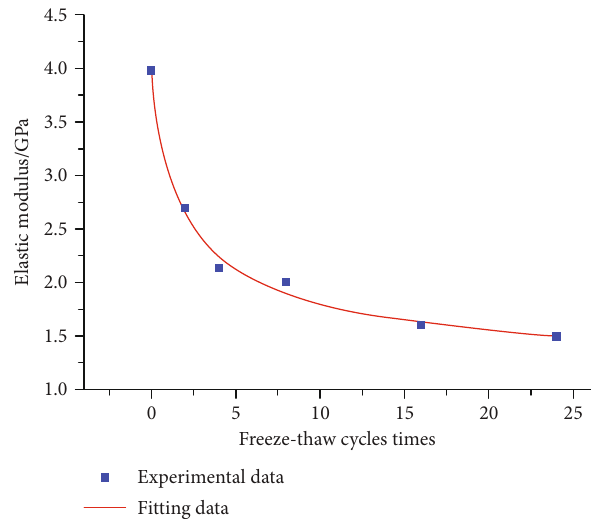
Figure 11: Elastic modulus of oil shale sample varies with the number of freeze-thaw cycles.